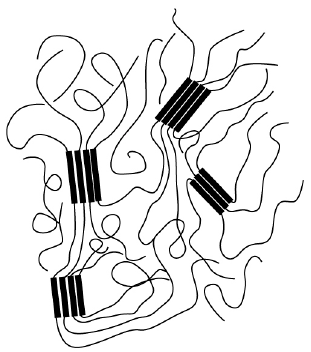
Figure 1. Schematic picture of the fringed micelle model.